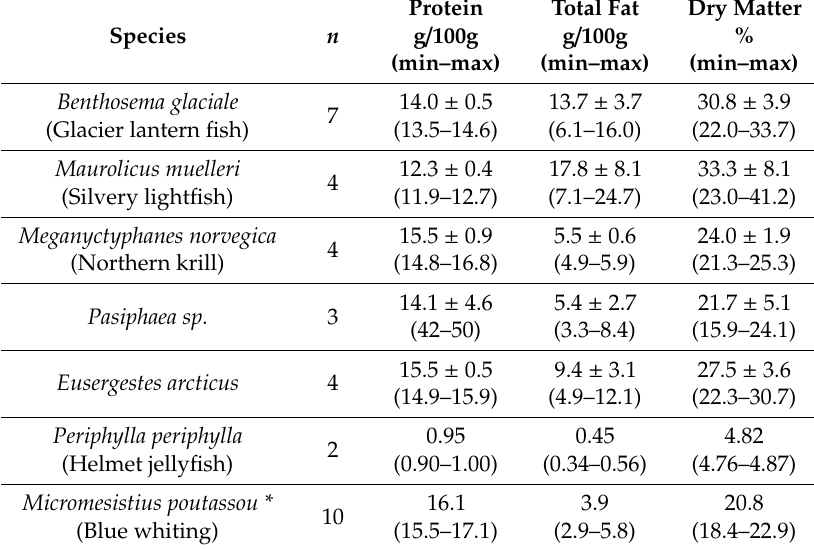
Table 2. Analytical wet weight-based values for protein, total fat and dry matter in six mesopelagic species caught in three fjords in western Norway, and Blue whiting for